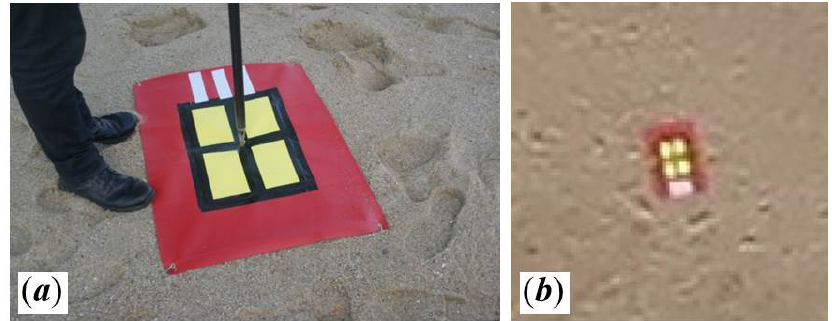
Figure 2. Example of an artificial ground control point (GCP) measuring 100 × 65 cm: in ( a ) the ground being surveyed with a global navigation satellite system (GNSS) device placed in the middle of the marker, and in ( b ) an aerial image taken using an unmanned aerial system (UAS) flying at 175